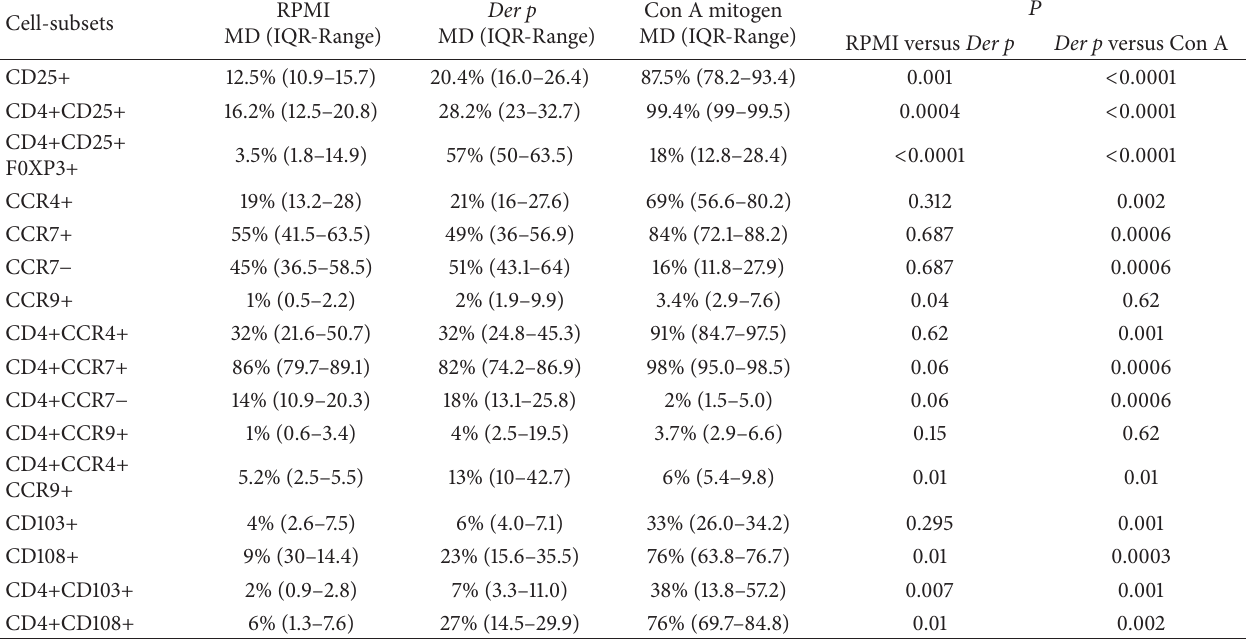
Table 2: Frequencies of cell-subsets and cell-migration receptors after Der 𝑝 -stimulation.